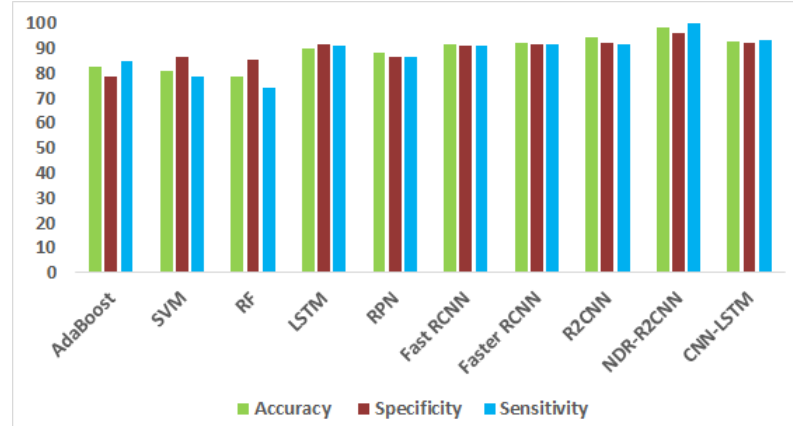
Figure 5. Comparison results of accuracy, specificity and sensitivity for various